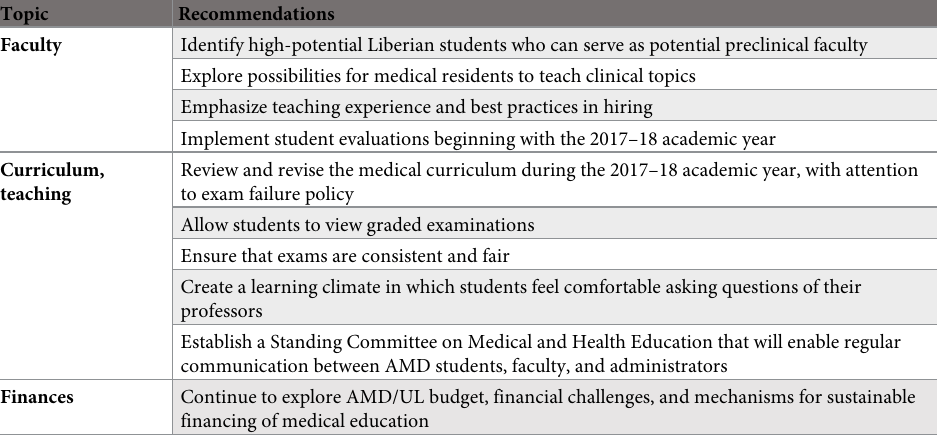
Table 7. Consensus recommendations for improving undergraduate medical education in Liberia, developed in response to 2016 study